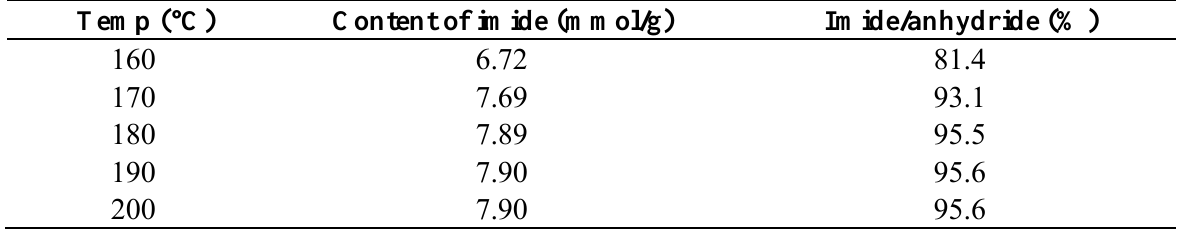
Table 1. Imide content of the products under different temperatures.